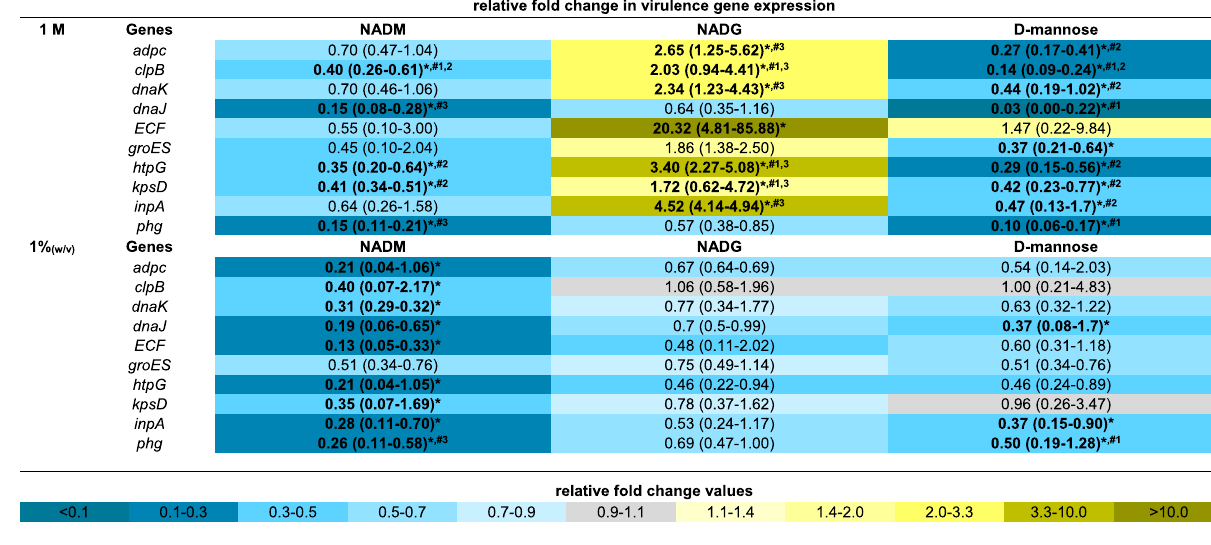
Table 4. Comparison of the effects of repeated multi-species biofilm rinsing with NADM, NADG or d-(+)-mannose on P. intermedia virulence gene expression. Fold changes in virulence gene expression were determined relative to the control condition through the 2 −ΔΔCt method and are shown as the geometric mean (C.I.) (n = 3) of the 2 −ΔΔCt values. All substrates were dissolved in PBS at 1 M (upper part) or ~ 0.05 M (1% (w/v) ) (lower part) (0.045 M (NADM and NADG) and 0.056 M (d-(+)-mannose)). Values between 0 and 1 represent relative downregulation, values > 1 represent relative upregulation. Statistically significantly different fold changes relative to the control (PBS) that are < 0.5 (> twofold downregulated) or > 1.5 (> 1.5-fold upregulated) are considered biologically relevant and are shown in bold and marked with ‘ * ’ ( P < 0.05, ANOVA + Dunnett’s correction for simultaneous hypothesis testing). For such values, statistically significant differences between two treatment conditions are marked with ‘ #1 ’ (vs. NADM), ‘ #2 ’ (vs. NADG), ‘ #3 ’ (vs. d-(+)-mannose) and shown in bold ( P < 0.05, ANOVA + Tukey’s correction for simultaneous hypothesis testing for comparisons between 3 substrates, unpaired two-tailed t-test for comparisons between 2 substrates). Statistically significantly different values between treatment conditions were only considered relevant if each condition was also significantly different from the control condition and only such differences are indicated. Color code: magnitude of the fold change in gene expression relative to the control. NADM: N -acetyl-d-mannosamine; NADG: N -acetyl-d- glucosamine; C.I.: 95% confidence